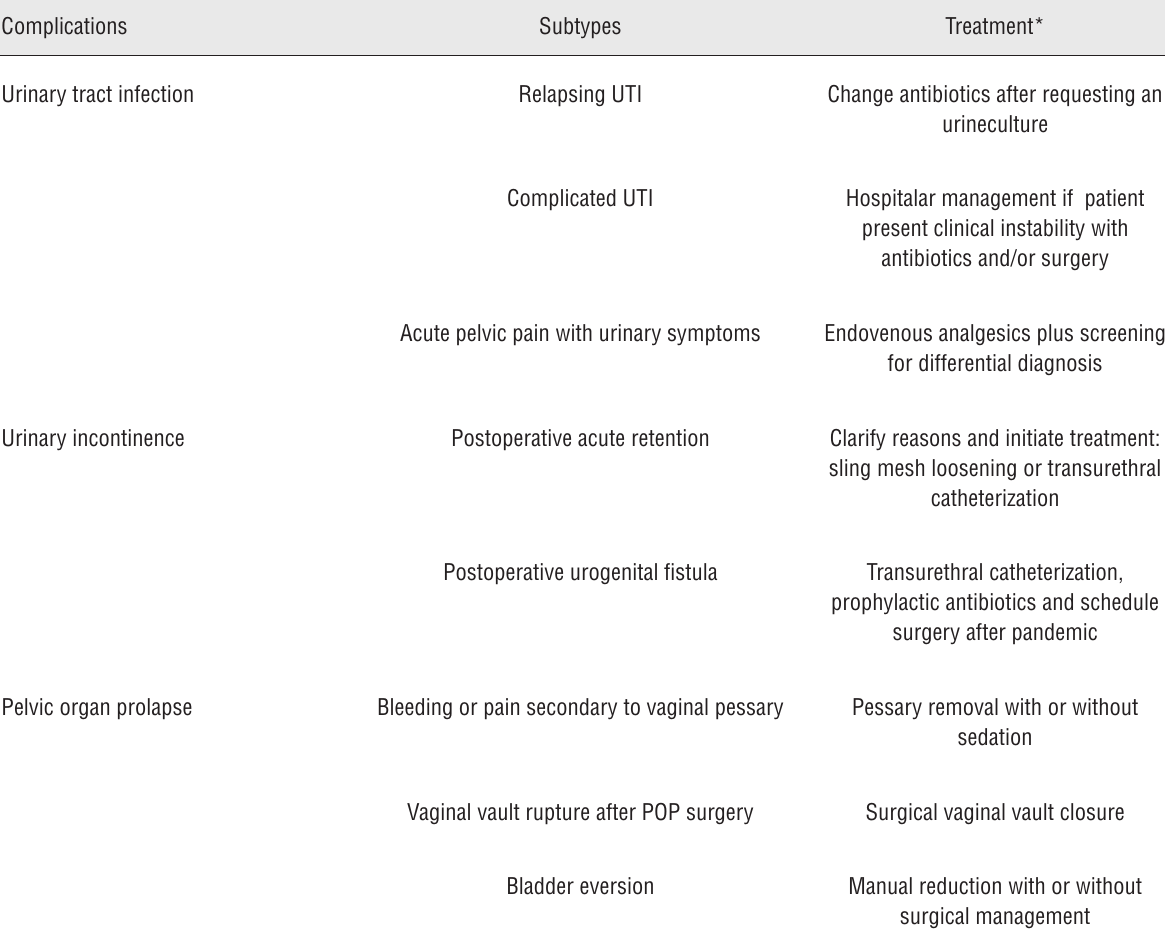
Table 1 - Complications from main disorders in Female Urology that may demand a visit during COVID-19